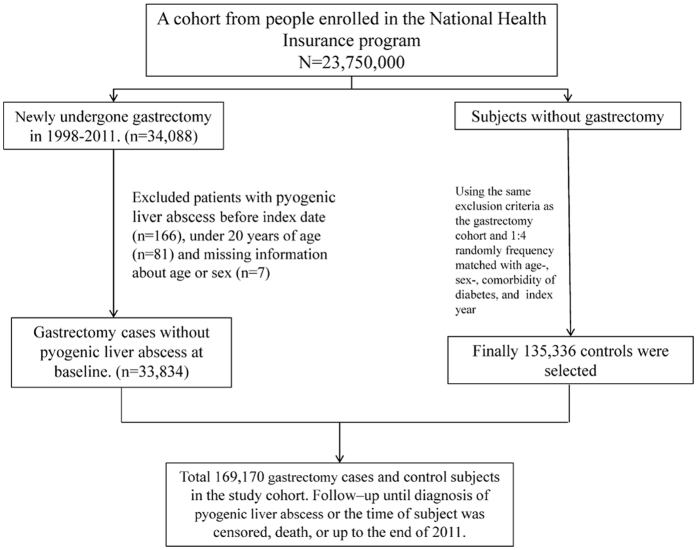
The flow chart shows the study subjects’ selection.